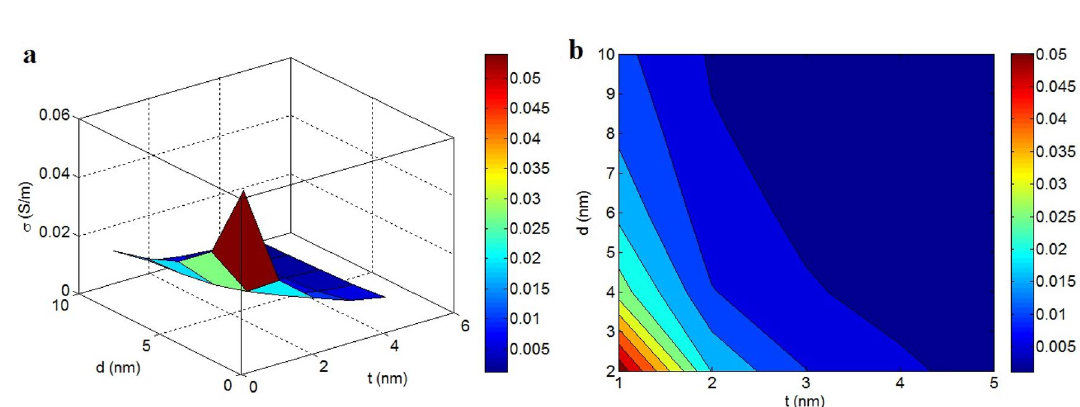
Figure 3. Conductivity by the variation of t and d provided by the new model: ( a ) 3D and ( b ) contour